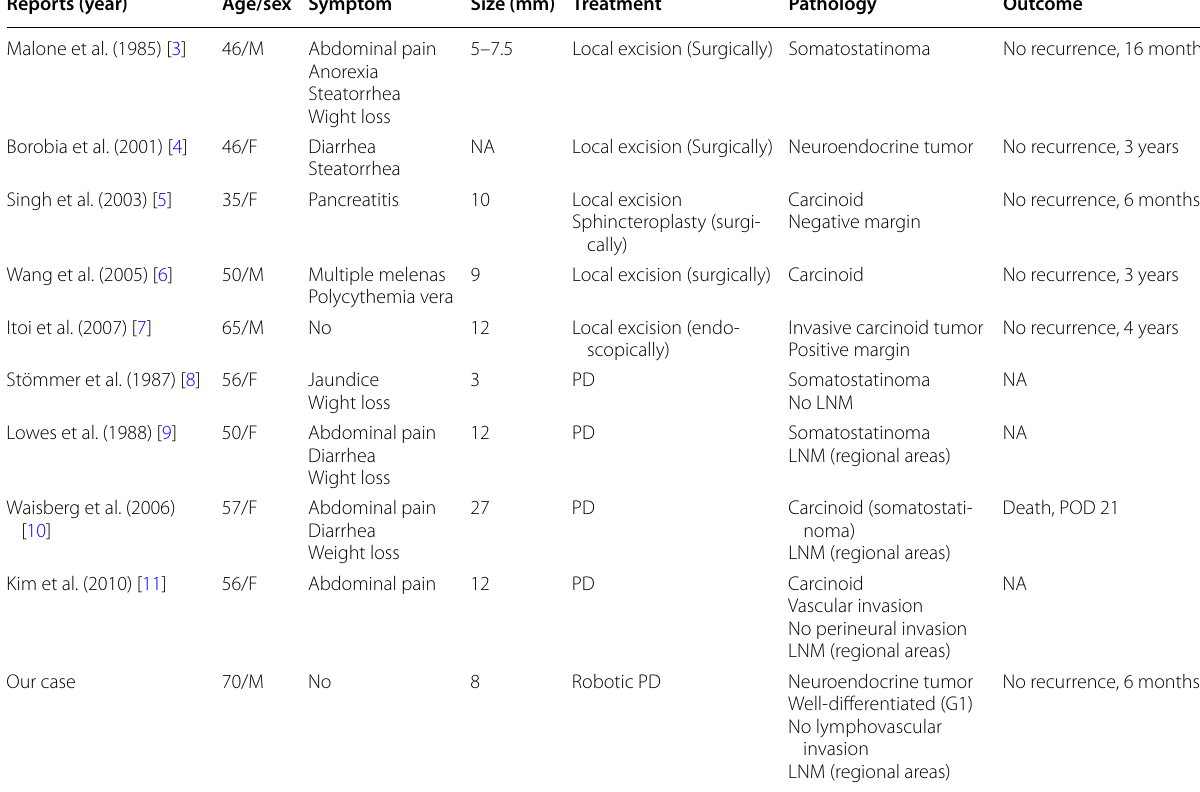
M male, F female, PD pancreatoduodenectomy, LNM lymph node metastasis, NA not